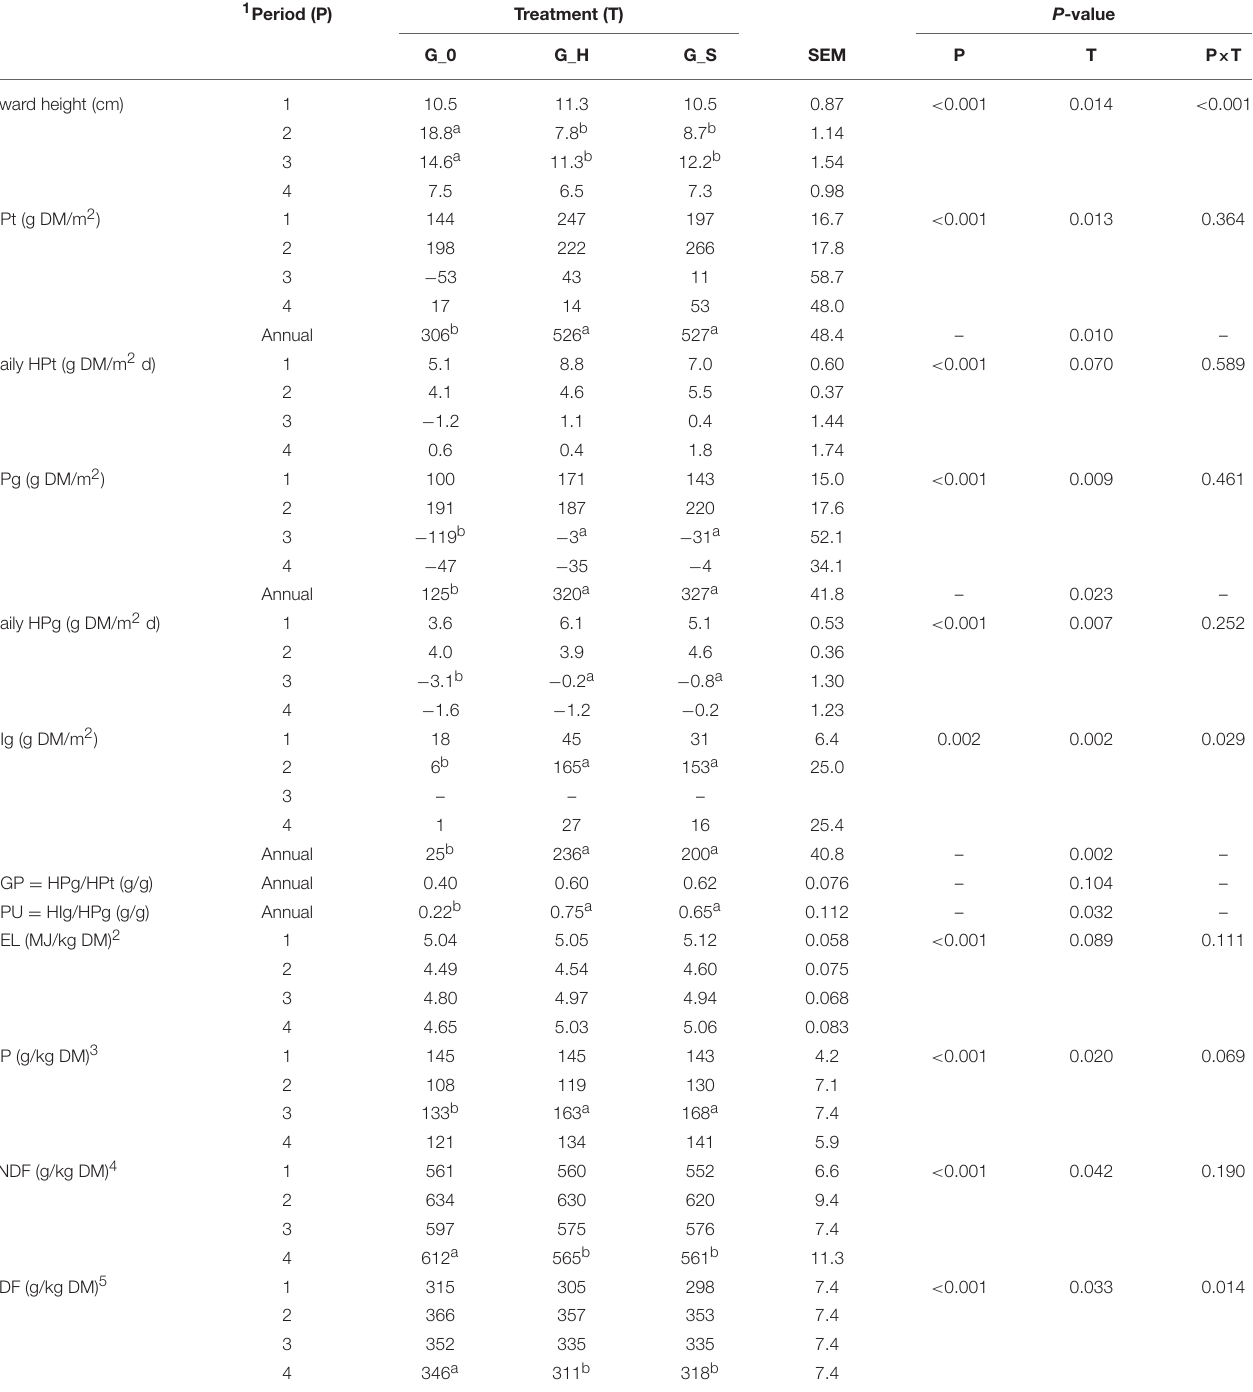
TABLE 3 | Effect of grazing treatment, Control without grazing (G_0), grazing with heifers (G_H) or grazing with sheep (G_S), during the summer period on total (HPt) and forage (HPg) dry matter (DM) production (g/m 2 and g/m 2 and day), estimated DM intake of forage (HIg) DM (g/m 2 and g/m 2 and day), forage proportion of total biomass produced (HGP, g/g), the proportion of consumed biomass of forage biomass produced (HPU, g/g) and feed quality ( n =